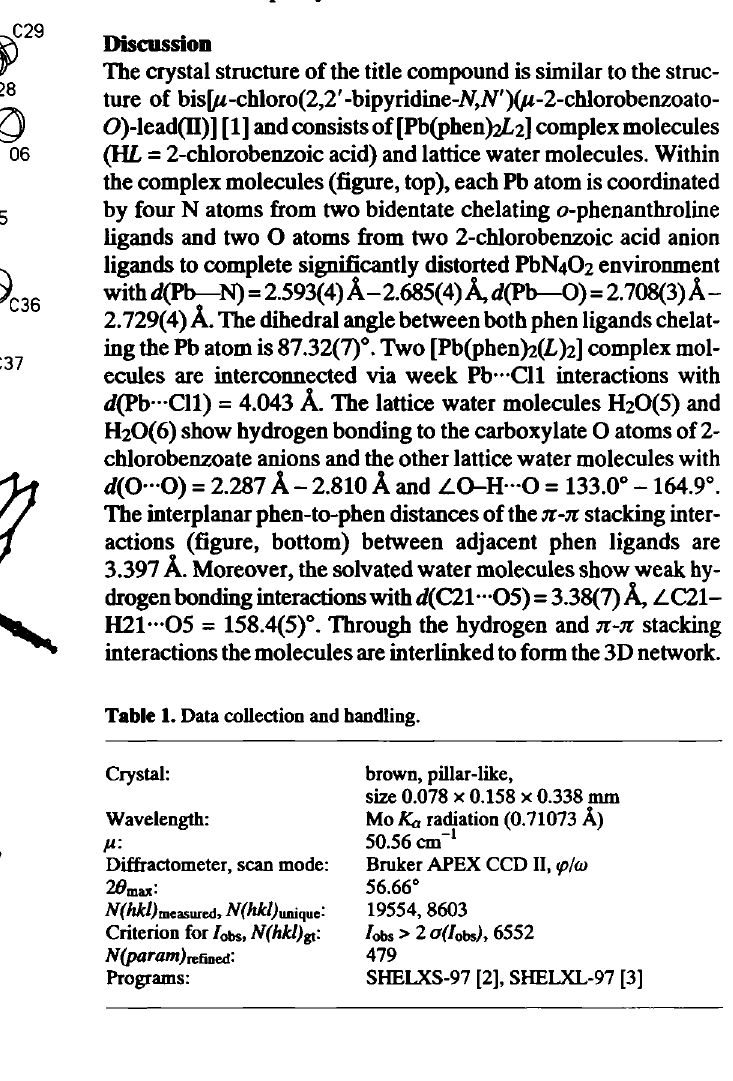
C 8H29Cl2N40 .5Pb, triclinic, PI (no. 2), a = 11.548(2) A, 3 6 b = 12.532(3) A, c = 13.661(3) A, a = 95.34(3)°, β = 112.60(3)°, γ = 103.23(3)°, V = 1740.4 Ä 3 , Ζ = 2, Rgt(F) = 0.037, wR (F 2 ) = 0.082, T= 293 Κ. Kf